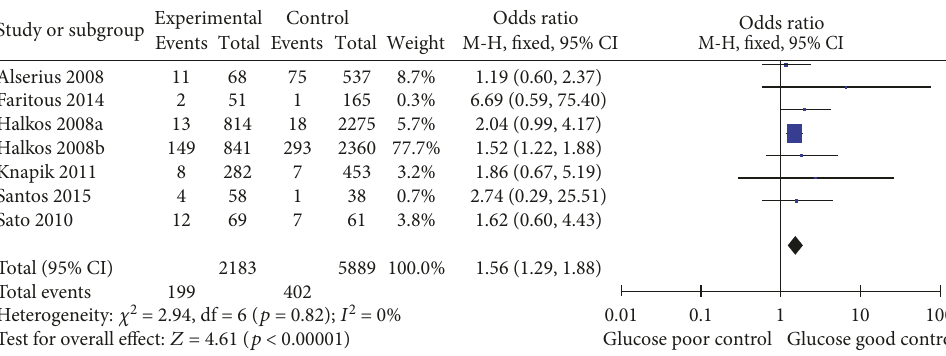
Figure 2: Forest plot of the relationship between HbA1c level and all-cause